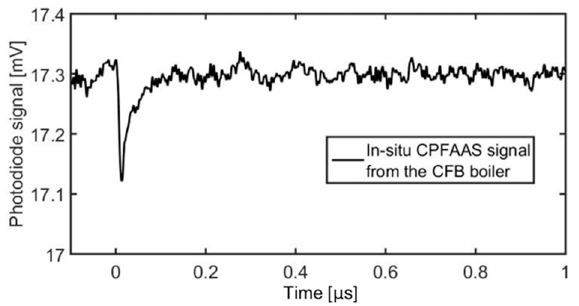
Figure 6. Example of a smoothed CPFAAS signal obtained directly from a full-scale power plant. The signal was obtained from 10-m-wide flue gas channel. Table 1. Measurement parameters and main results from PbCl 2 detection through a 10-m-wide flue gas passage using the CPFAAS prototype.